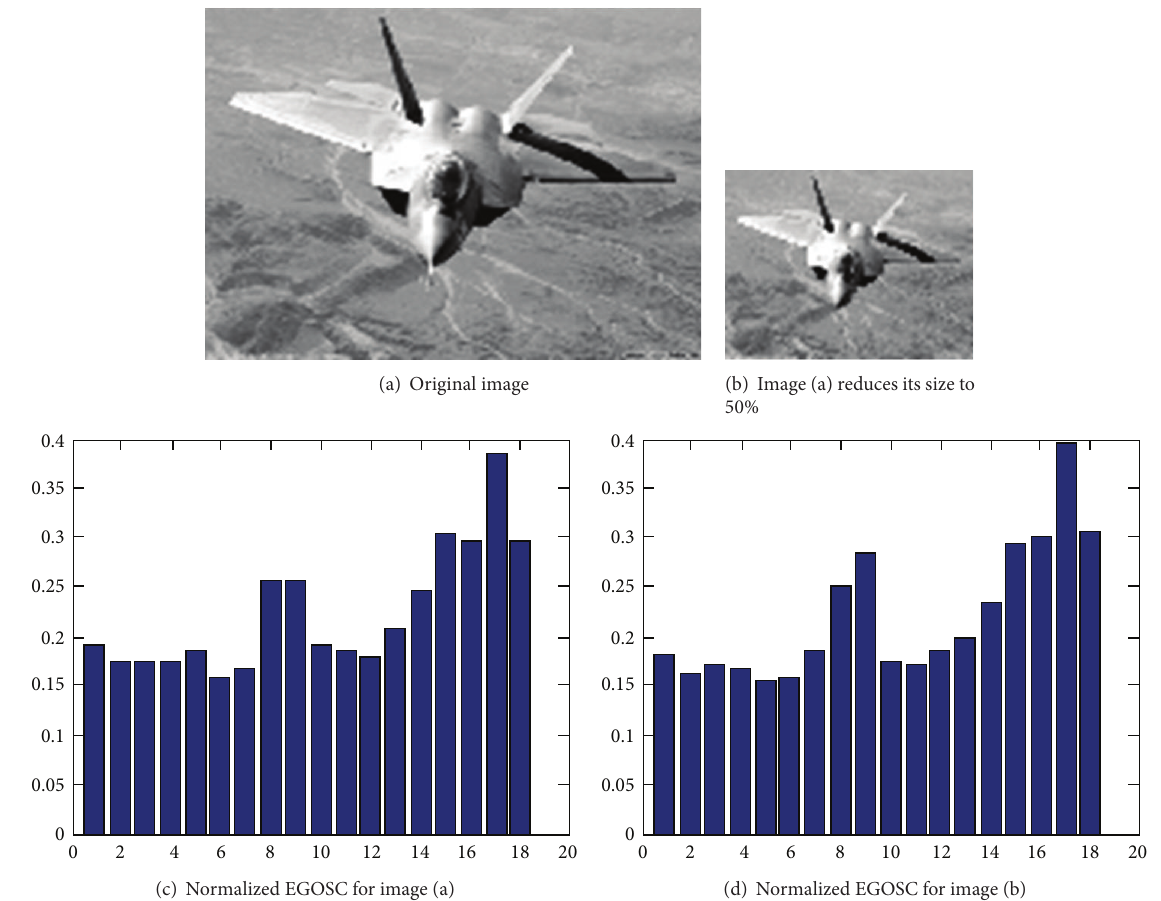
Figure 4: EGOSC histograms for images with varied